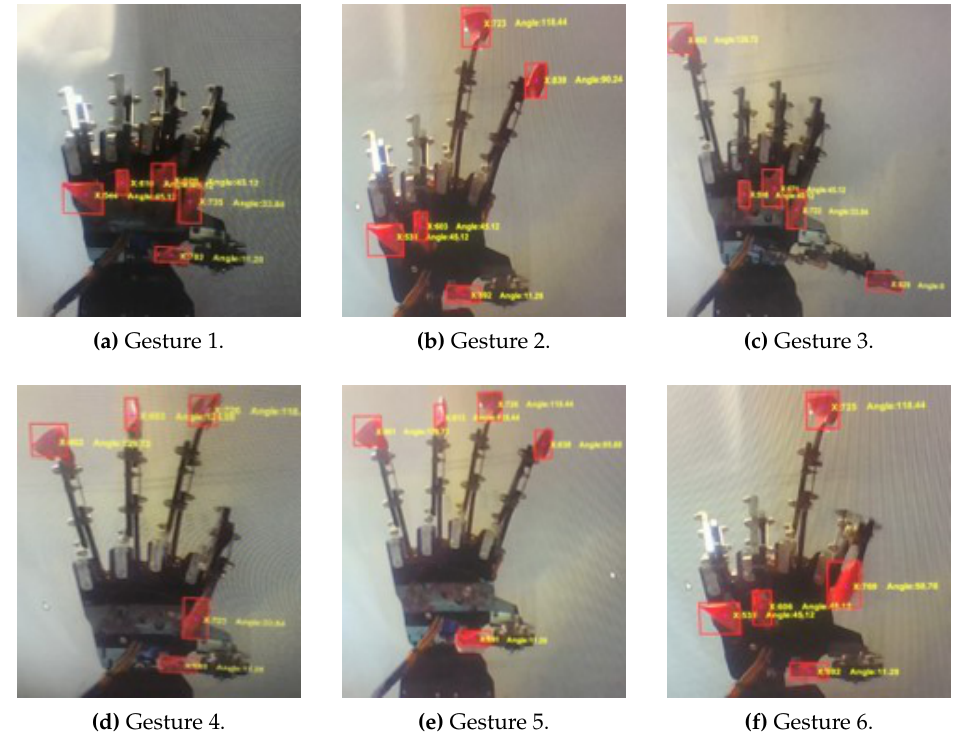
Figure 25. Bionic hand gestures during the image processing in MATLAB from the six